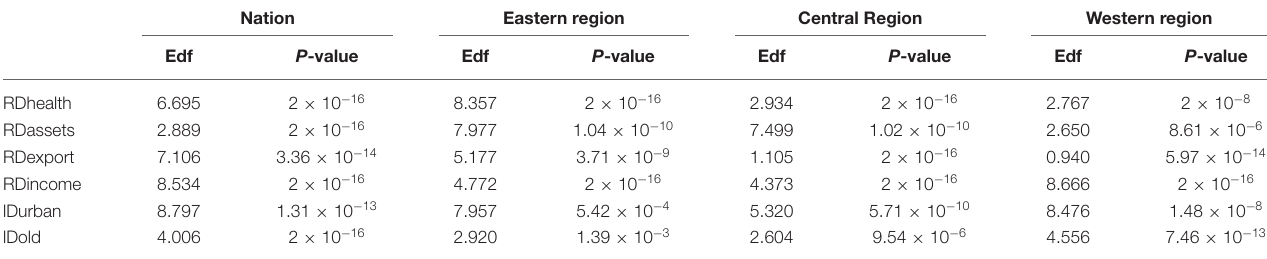
TABLE 5 | Estimation results of non-linear part. Nation Eastern region Central Region Western